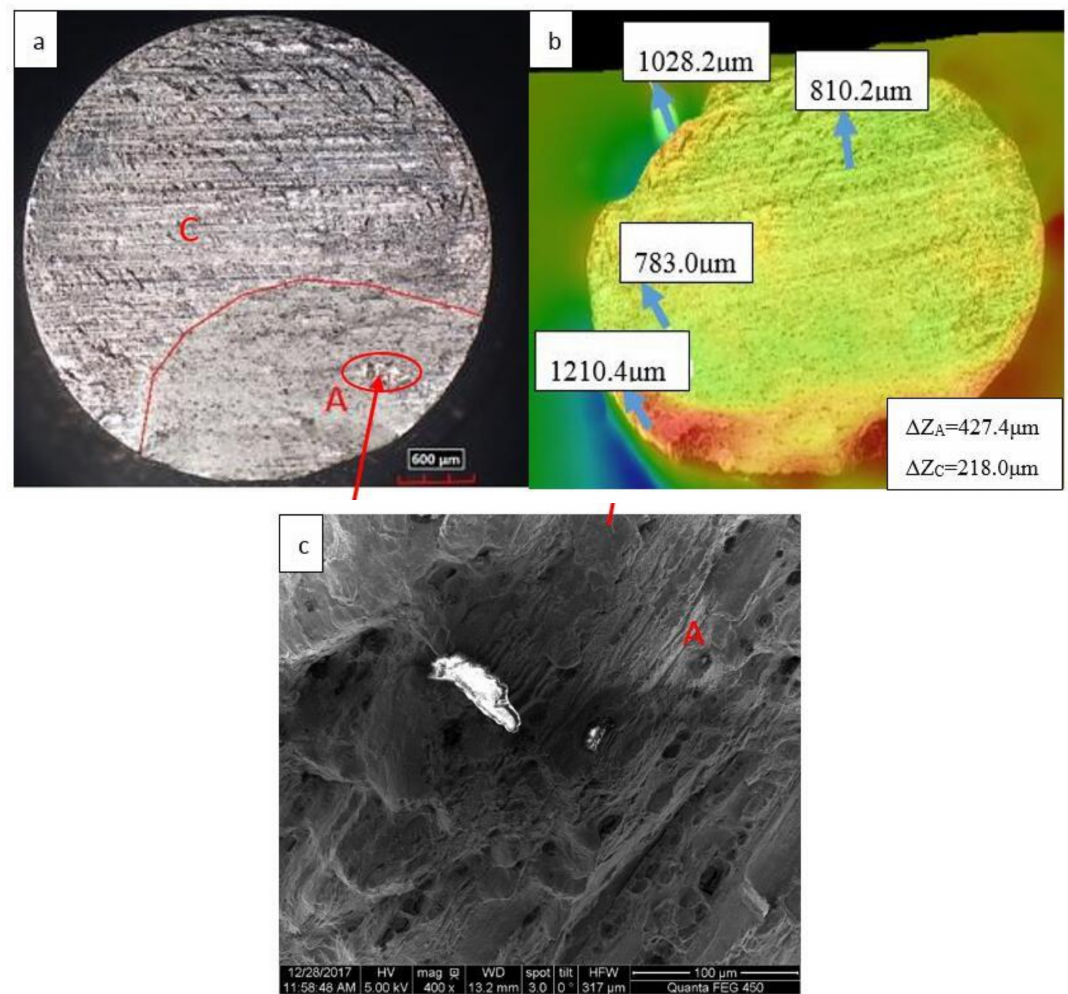
Figure 2. Fatigue fracture surface of N f = 7.552 × 10 5 , σ = 113.3 MPa in air for the uncoated sample. ( a ) Macro-scale view of the fracture surface; ( b ) Three-dimensional view of the fracture surface; ( c ) Enlarged view of ellipse in ( a